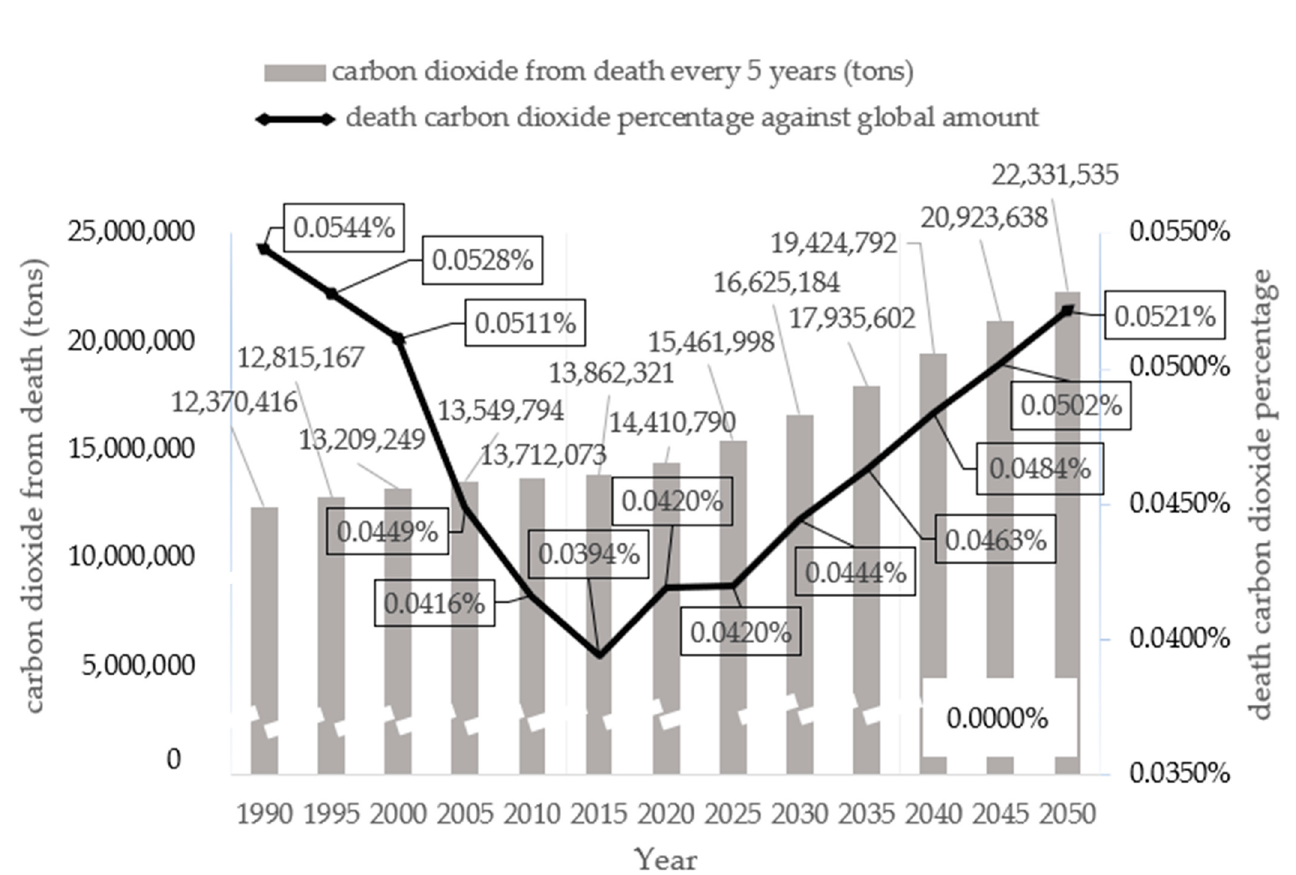
Figure 2. Trend of carbon dioxide generated from deaths every 5 Figure 3. The simulation of carbon dioxide generated from the death toll from 10% to 30% every 5 years between 2030 and 2050.